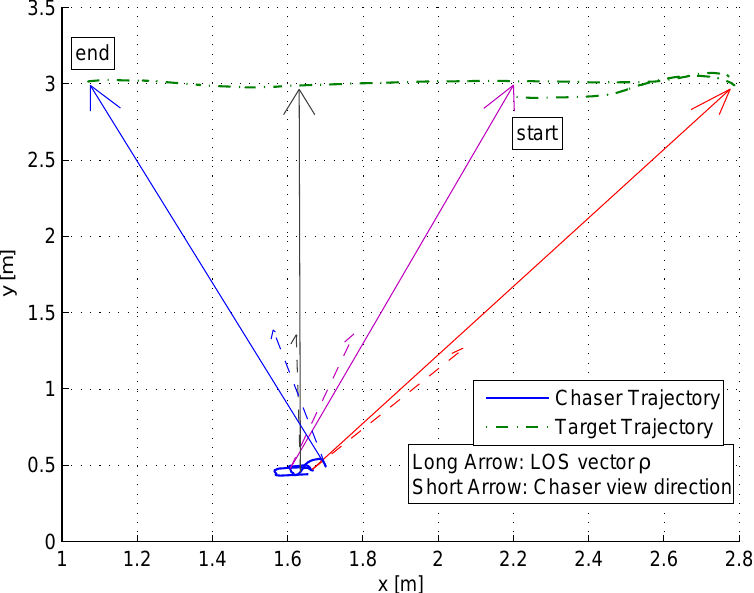
Figure 19. The trajectory of the target and the chaser including the LOS and body directions at different time